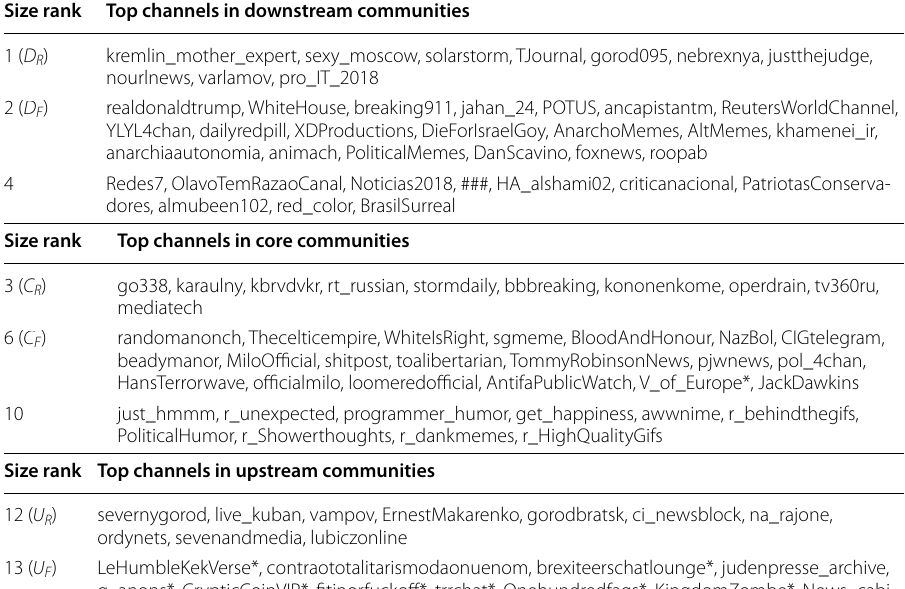
OlavoTemRazaoCanal is linked to a Brazilian far-right conspiracy theorist 6 and red_ color that broadcasts alerts of imminent attacks by rockets in Israeli settlements around Gaza. 7